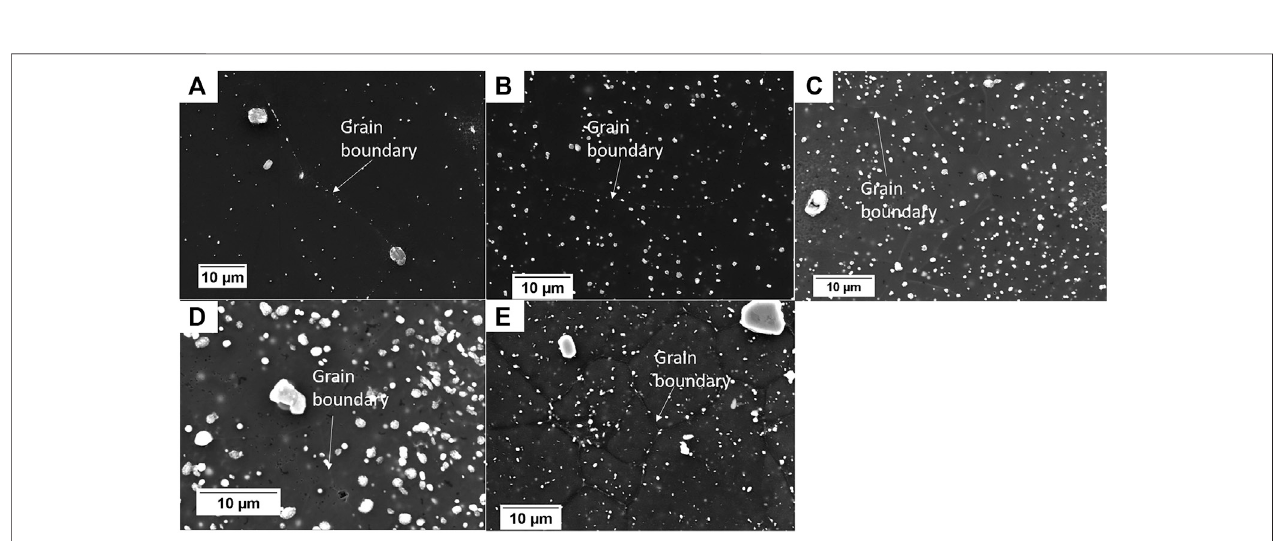
FIGURE 4 | SEM images showing microstructure of extruded (A) Mg-1Bi, (B) Mg-3Bi, (C) Mg-6Bi, (D) Mg-9Bi, and (E) Mg-9Bi-2.5Zn.